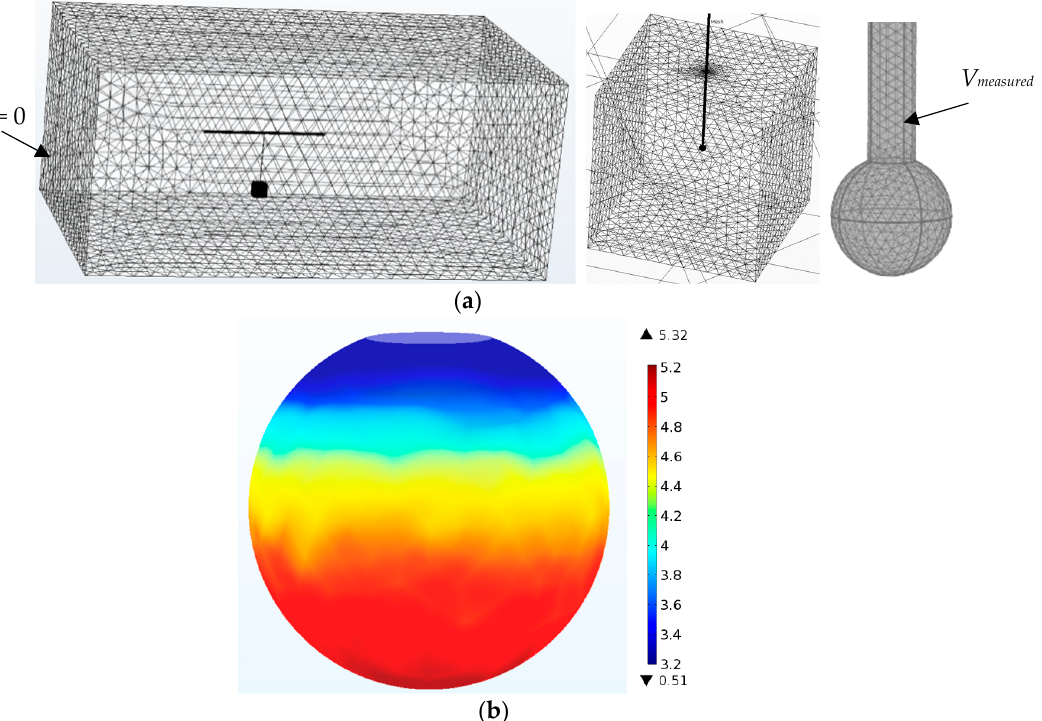
Figure 1. ( a ) Meshes of the analyzed geometries, including two boxes to refine the mesh, the spherical electrode, and the supporting cylindrical rod; ( b ) Electric field distribution on the surface of the spherical electrode.